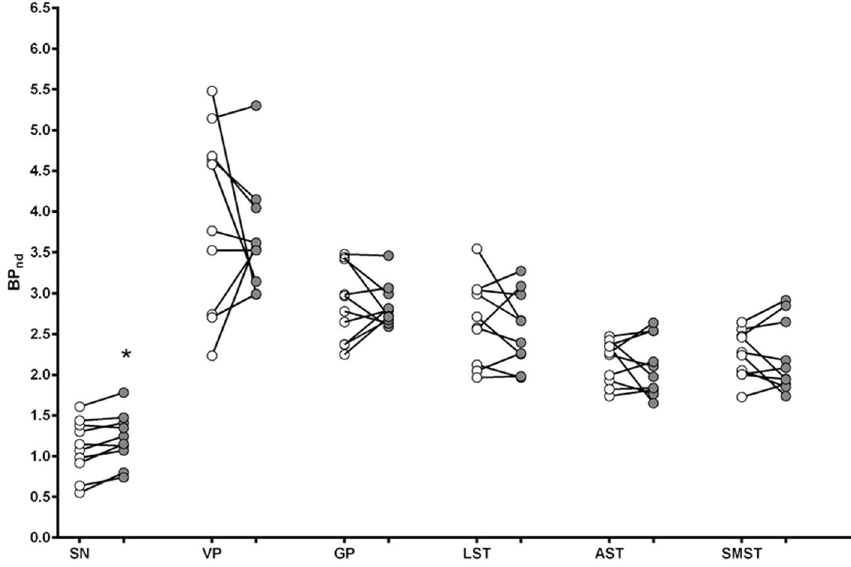
Figure 1. Binding potential (BP ND ) for the individual participants after presentation of the neutral cue (open symbols) or smoking cue (dark symbols). The horizontal line represents the mean of the group. SN substantia nigra; VP ventral pallidum; GP globus pallidus; LST limbic striatum; AST associative striatum; SMST sensorimotor striatum. *p < 0.0083, neutral cue different from smoking